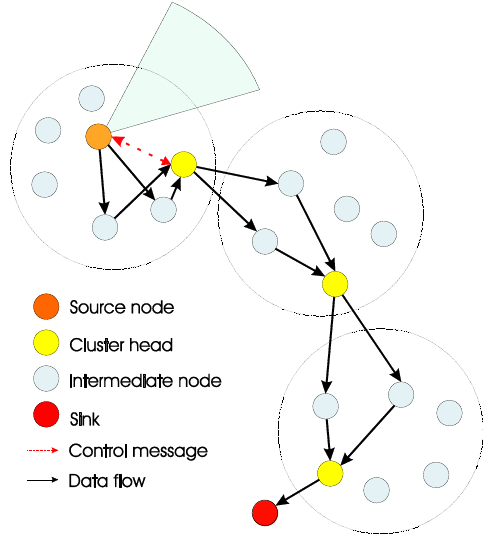
Figure 1. A cluster-based in-network image processing